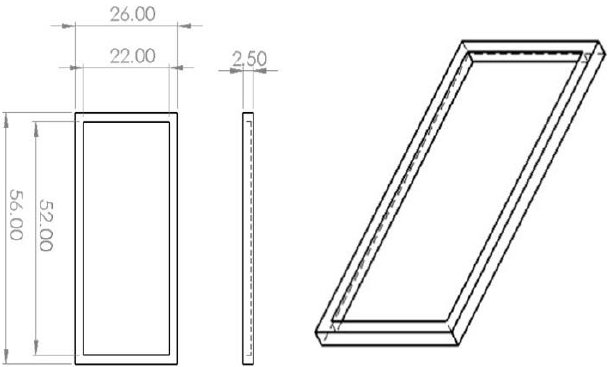
Figure 1. General characteristics of the 3D-printed plate device (in mm).